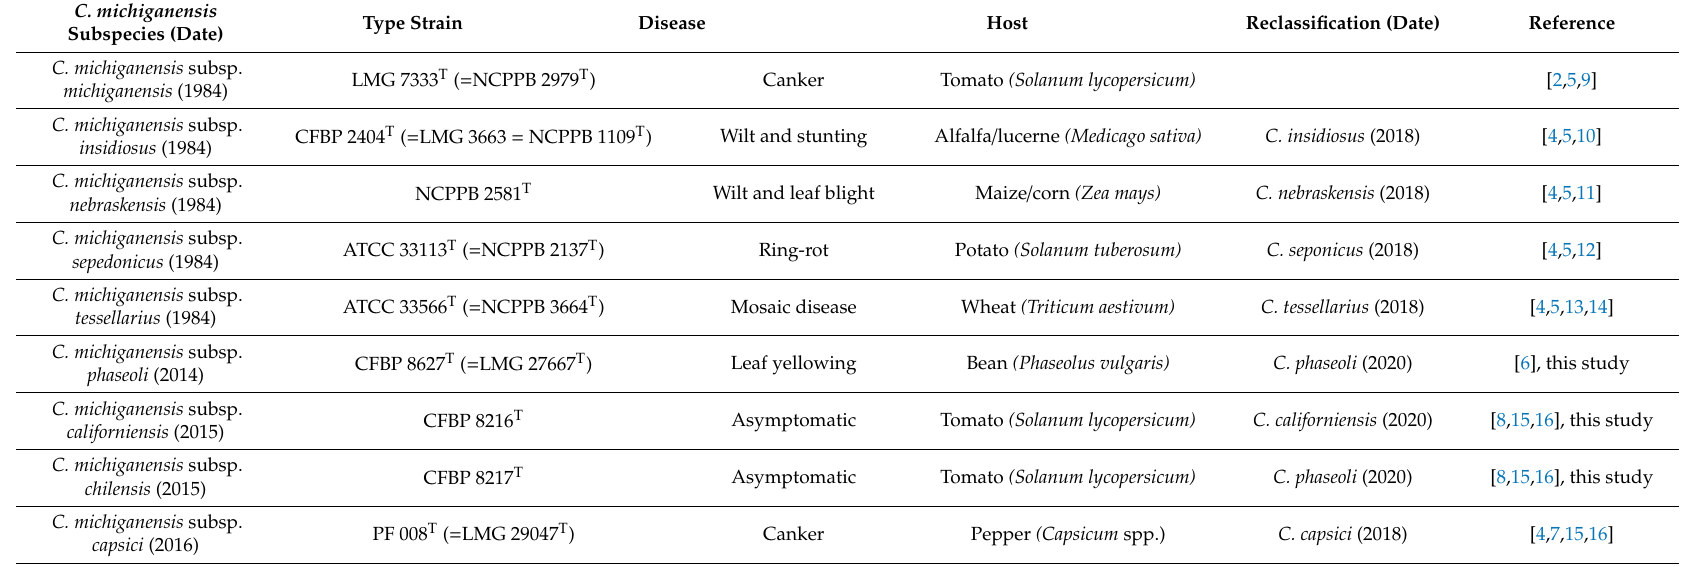
Table 1. Taxonomy of Clavibacter